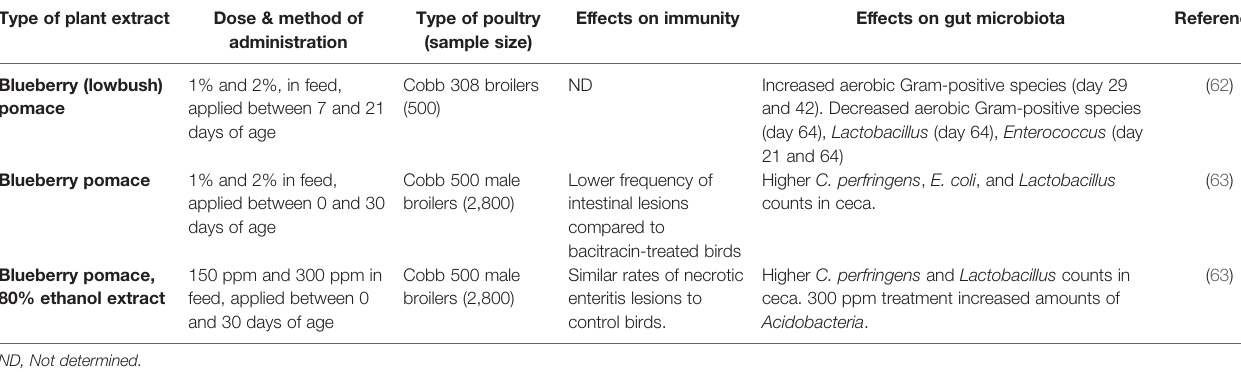
TABLE 2 | A comparison of in vivo feeding studies of blueberry byproducts and extracts in poultry, highlighting signi fi cant effects on the immune system and gut microbiota in live